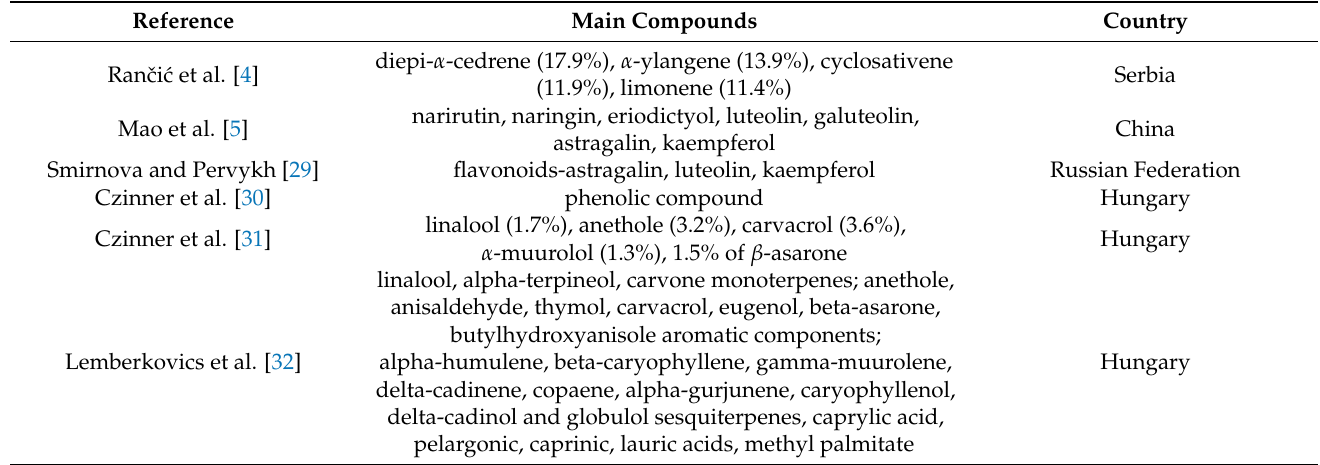
Table 1. Literature data of phytochemical research on Helichrysum arenarium